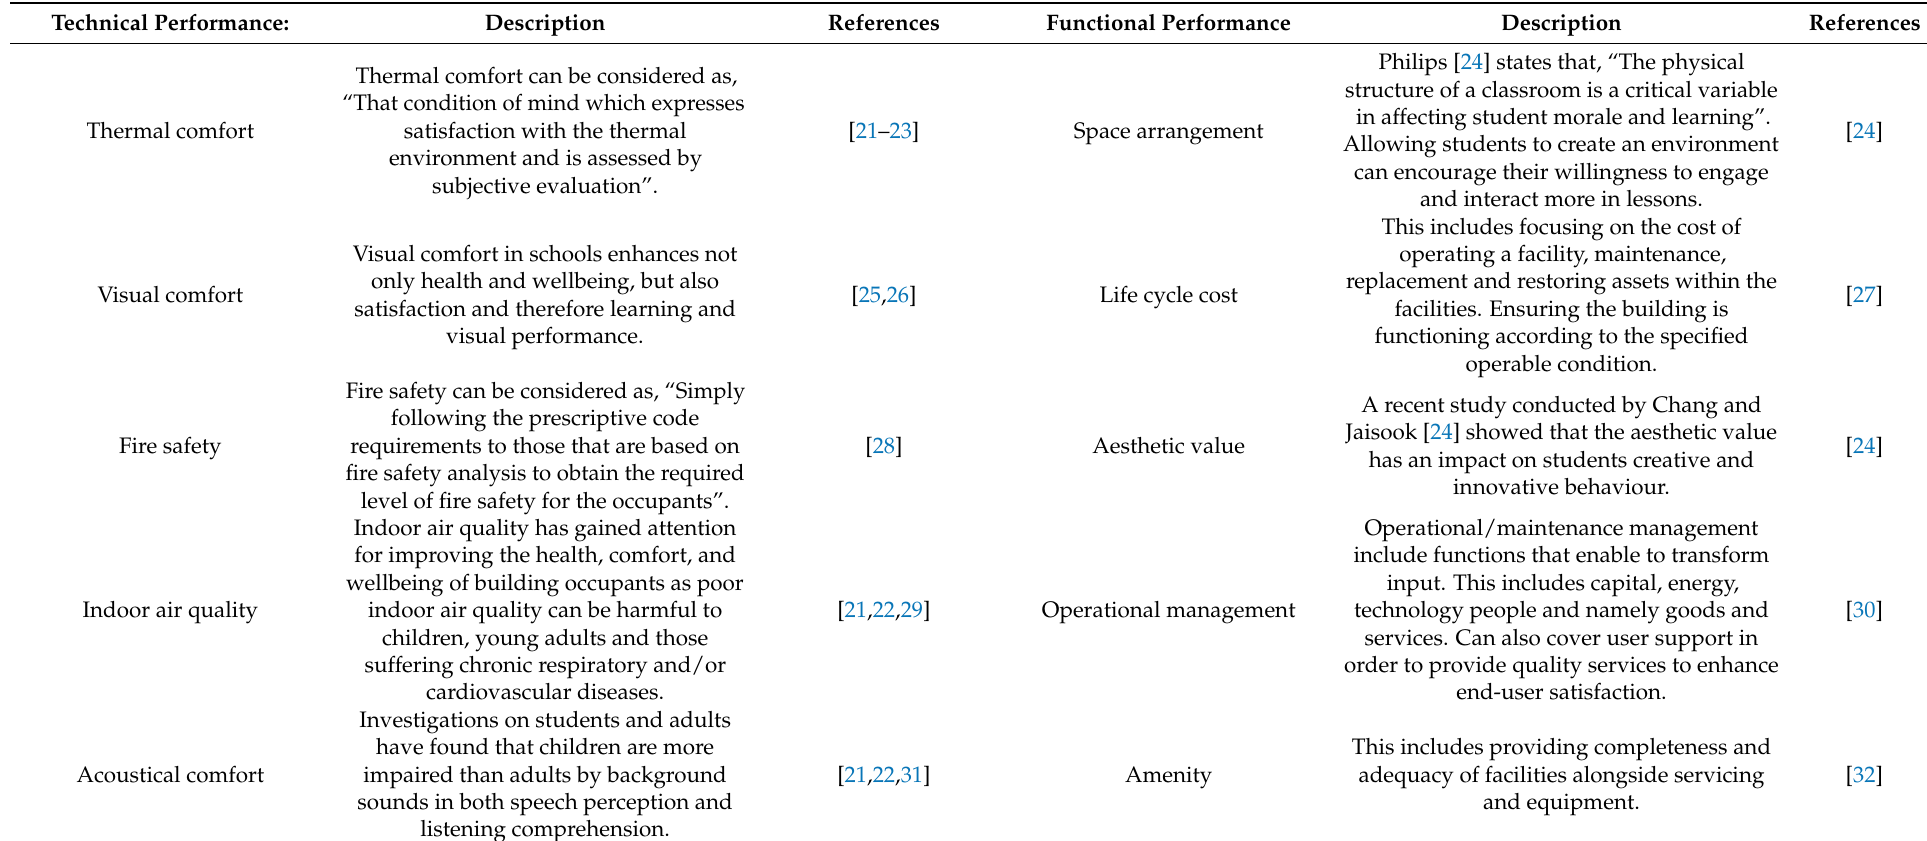
Table 1. Differences between technical and functional